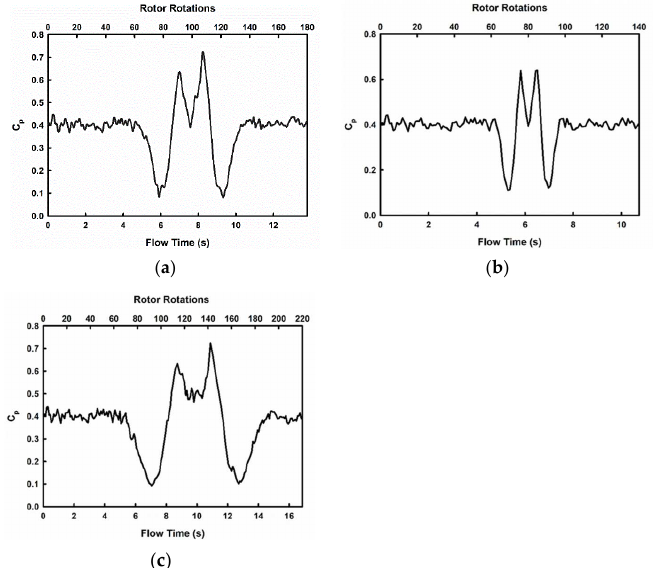
Figure 23. The variation of C p for flow time for one complete gust cycle gust time periods ( a ) 3 s; ( b ) 6 s; ( c ) 10.5 s.